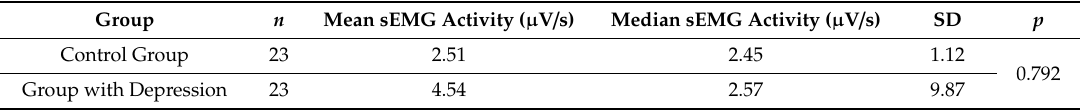
Table 3. The comparison of mean activity of temporal muscle (TA) in rest between the group without depression (control group) and the group with depression.